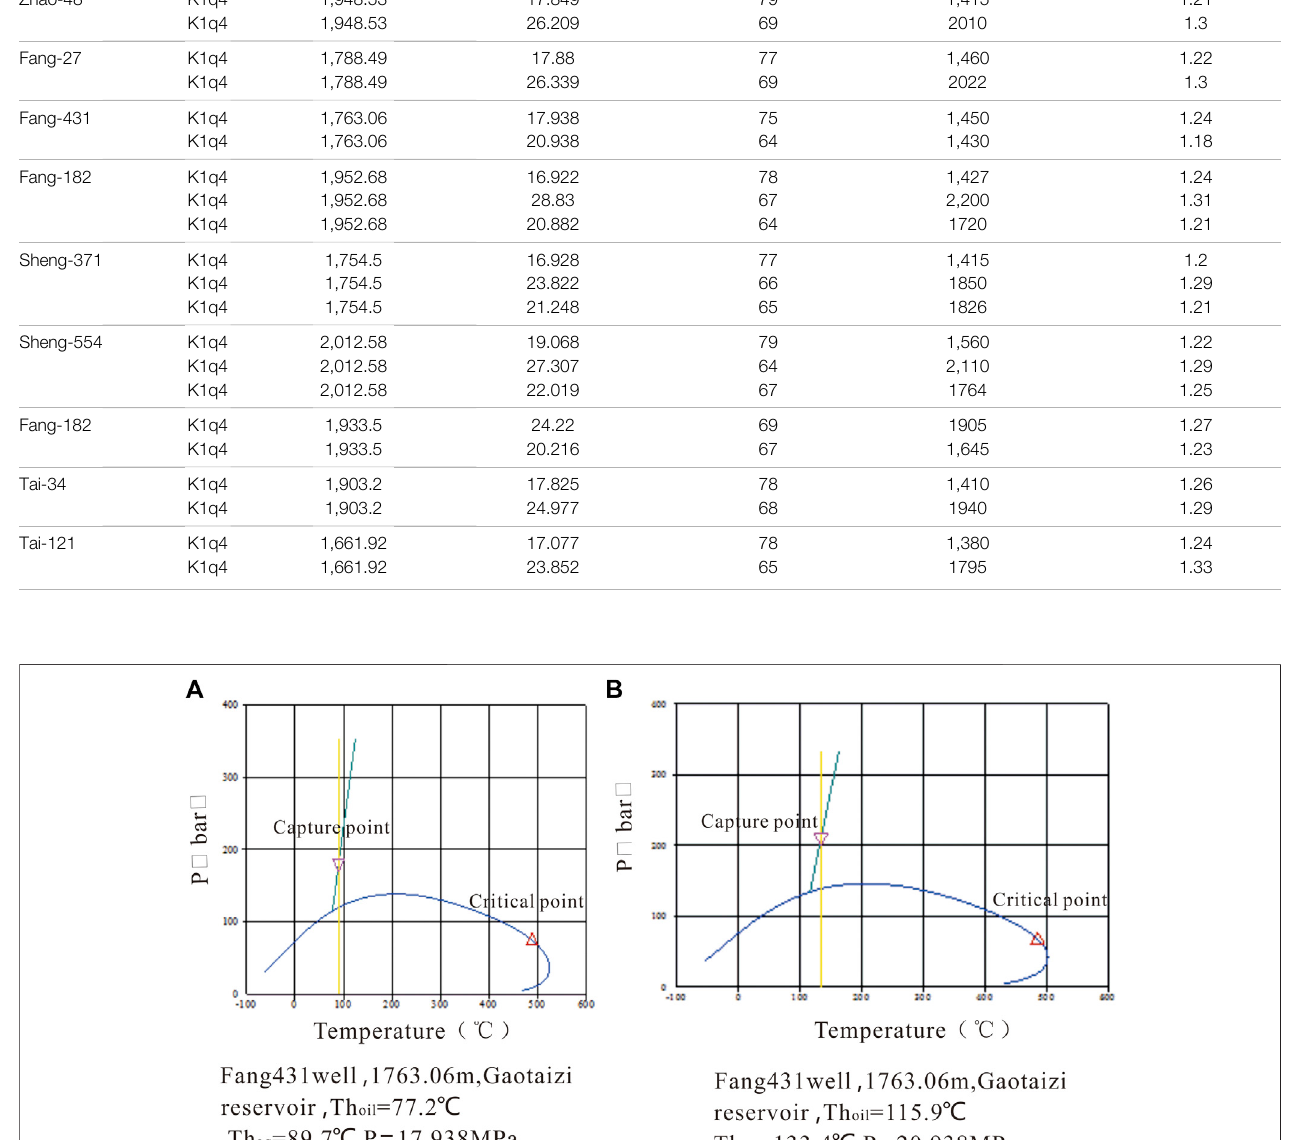
Frontiers in Earth Science |